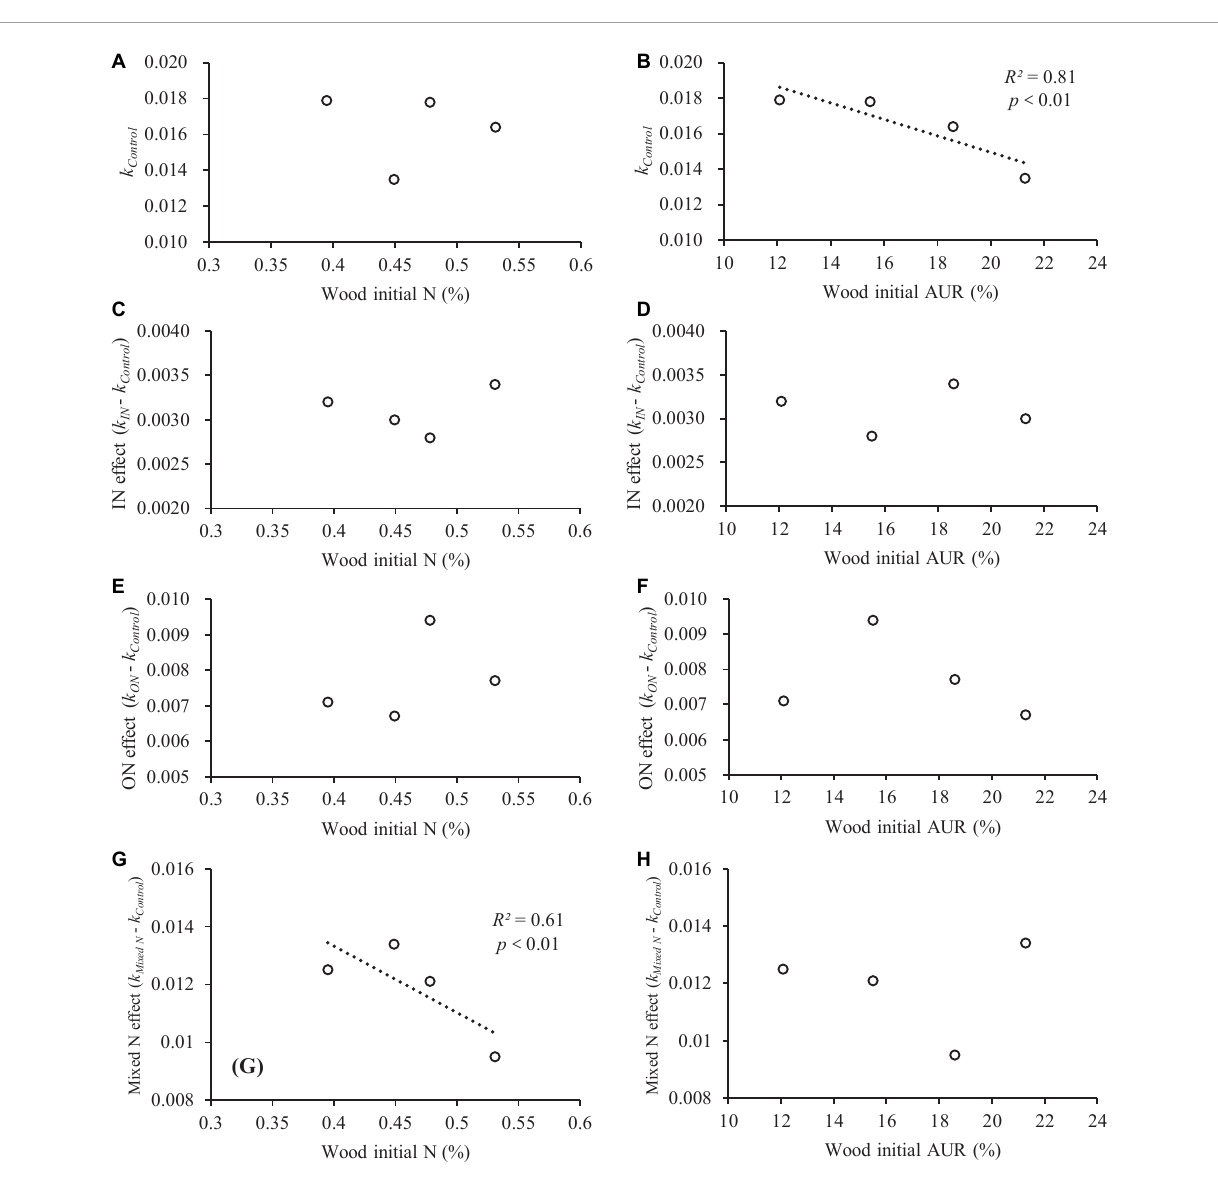
Frontiers in Forests and Global Change